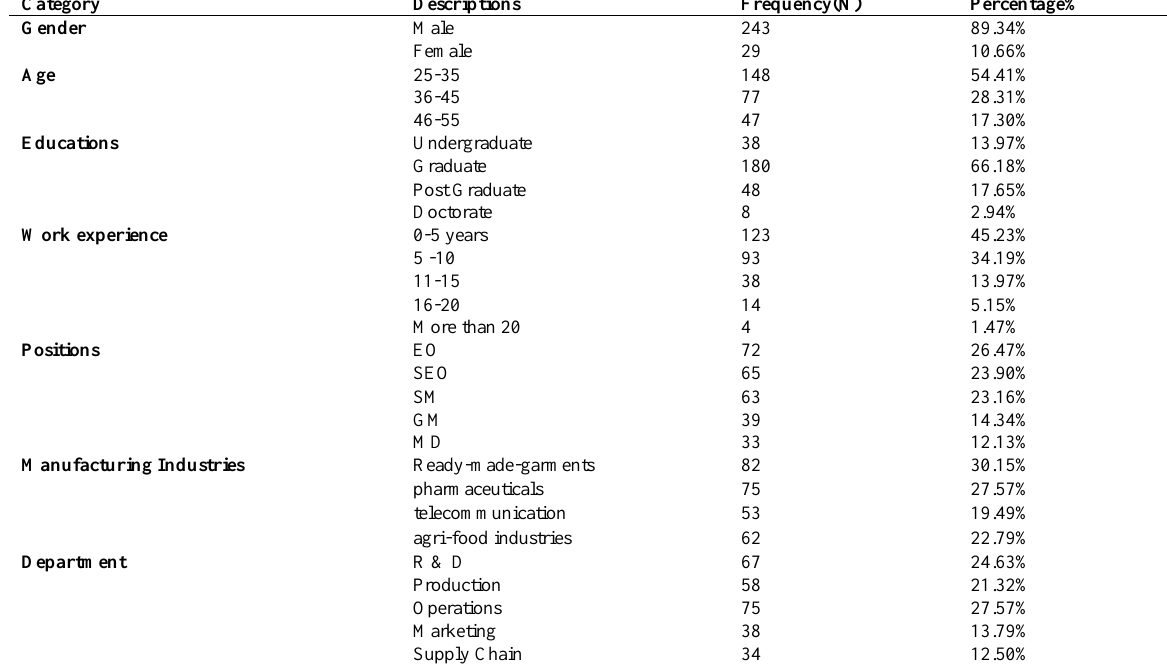
Table 1: Socio-demographics factors of the